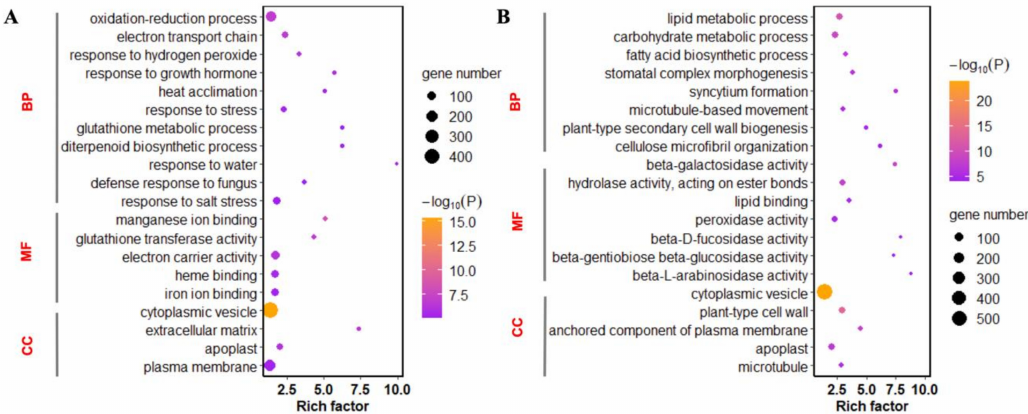
Figure 3. Gene Ontology (GO) enrichment analysis of up and down di ff erentially expressed genes (DEGs) in C and phosphite (PHI). Up-regulated genes ( A ) and down-regulated genes ( B